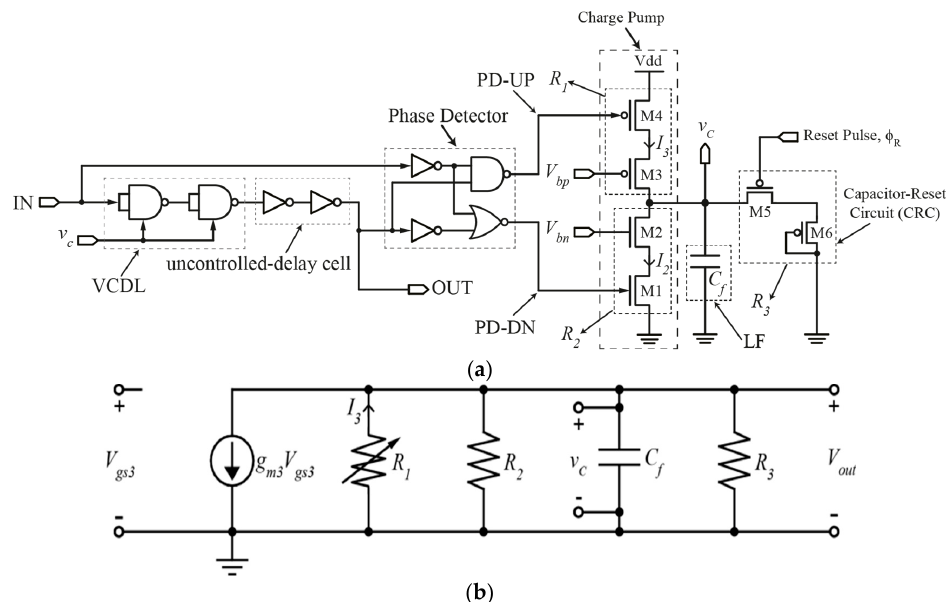
Figure 1. ( a ) Schematic of DLL with the CRC; and ( b ) small-signal model of DLL’s charge pump with CRC.